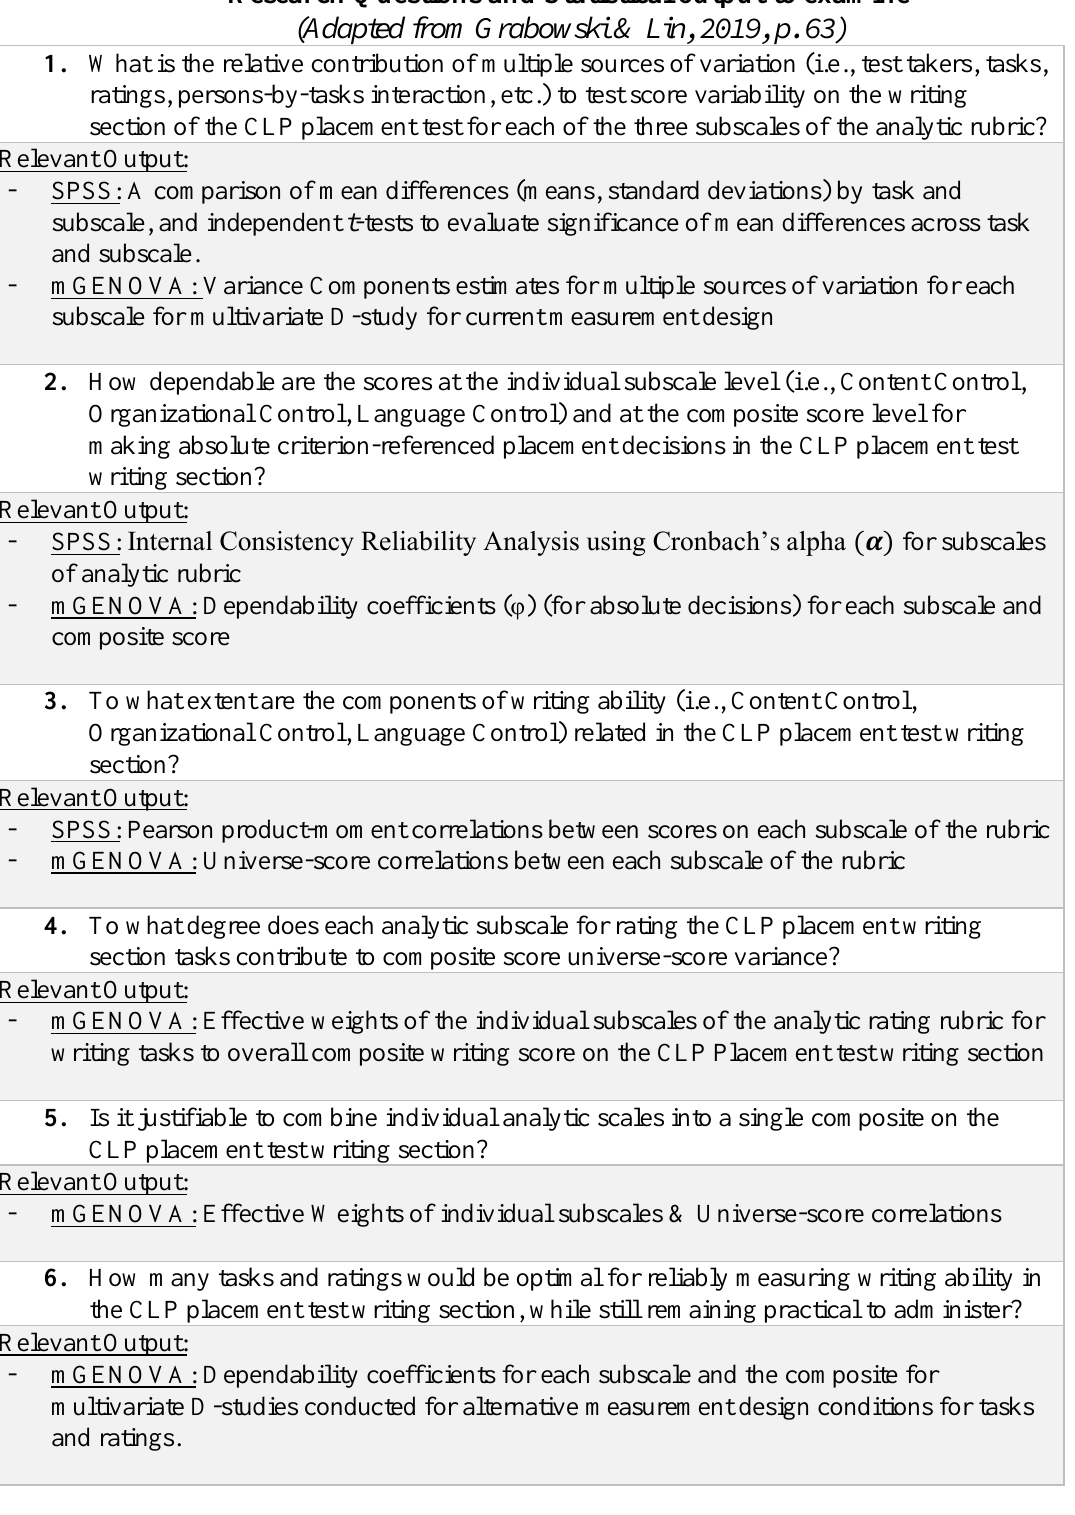
Research Questions and Statistical output to examine (Adapted from Grabowski & Lin, 2019, p.